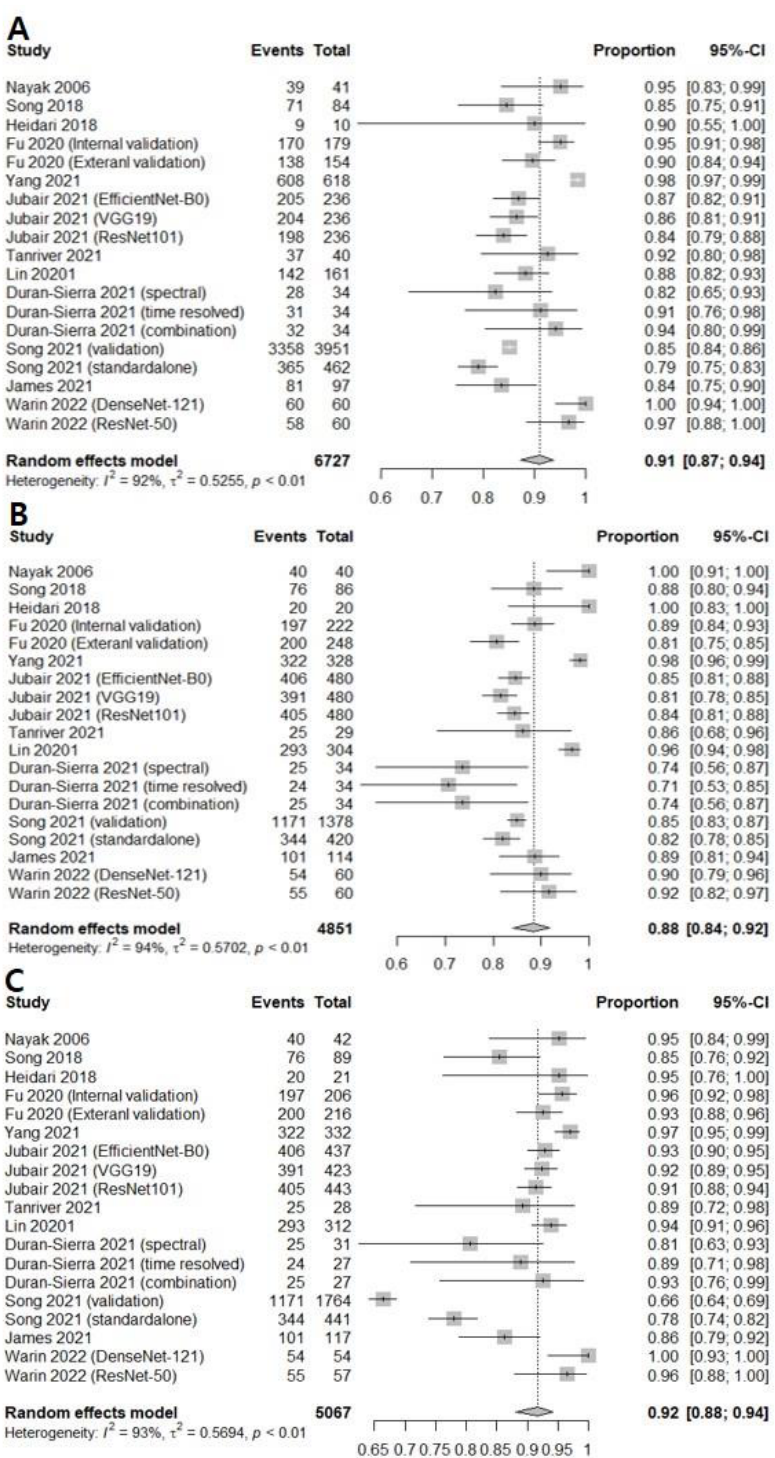
Figure 5. Forest plots of ( A ) sensitivity, ( B ) specificity, and ( C ) negative predictive values for screening all premalignant mucosal lesions [6,13 – 21,23,24]. The Egger ’ s test results of sensitivity ( p = 0.02025) and negative predictive value ( p < 0.001) also show that the possibility of publication bias is high. To compensate for the publication bias using statistical methods, trim-and-fill methods (trimfill) were applied to the outcomes. After implementation of trimfill, sensitivity dropped from 0.9094 [0.8725; 0.9364] to 0.8504 [0.7889; 0.8963] and NPV also dropped from 0.9169 [0.8815; 0.9424] to